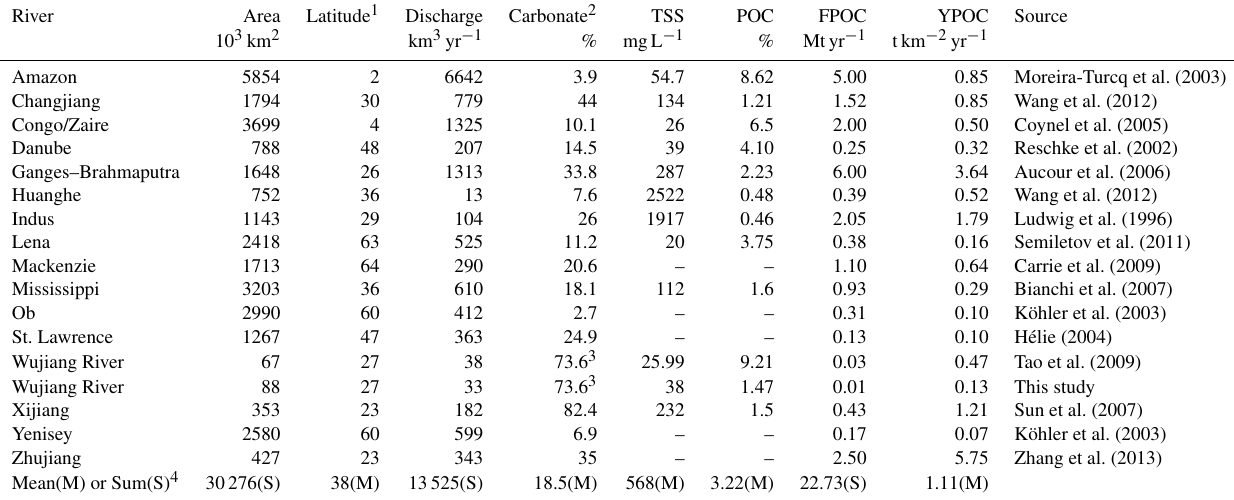
Figure 8. (a) Relationship between POC yield and latitude; (b) Relationship between POC yield and percentage of carbonate area (carbonate %). Latitude and percentage of carbonate area were taken from Cai et al. (2008) and Amiotte Suchet et al. (2003), respectively. Table 2. Particulate organic carbon fluxes (FPOC) and yields (YPOC) in some world rivers and the Wujiang River.